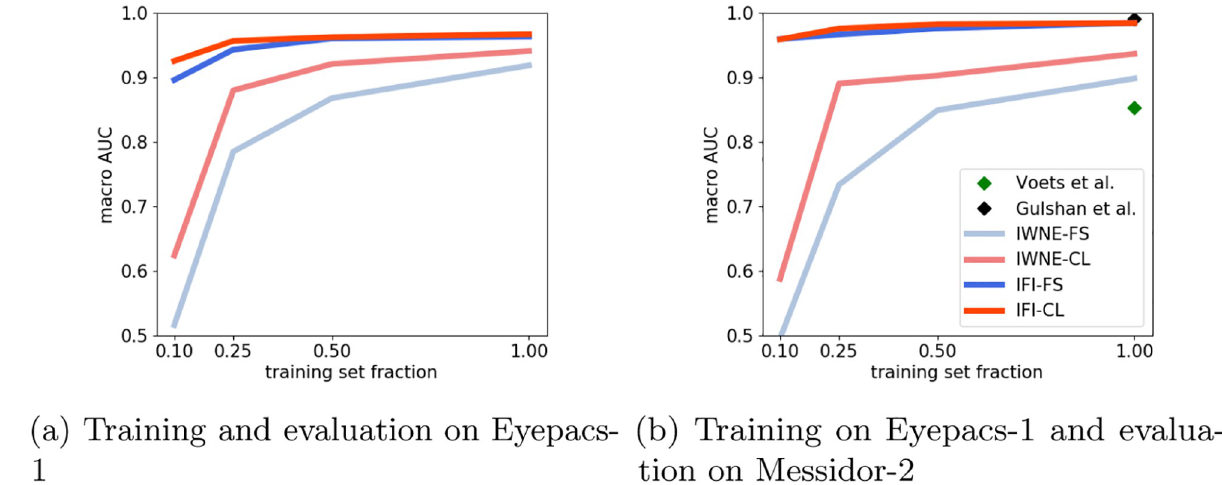
Fig 2. Classification performance on Eyepacs-1 and Messidor-2 dataset for referable DR. The x-axis in both the subfigures correspond to the fraction of the labeled training set from the Eyepacs-1 dataset used for the downstream training of the four different training procedures. The state-of- the-art method for DR—Voets et al. [3] and Gulshan et al. [2] are shown as green and black diamonds for training with the full dataset for the Messidor-2 dataset. (a) Training and evaluation on Eyepacs-1. (b) Training on Eyepacs-1 and evaluation on Messidor-2.